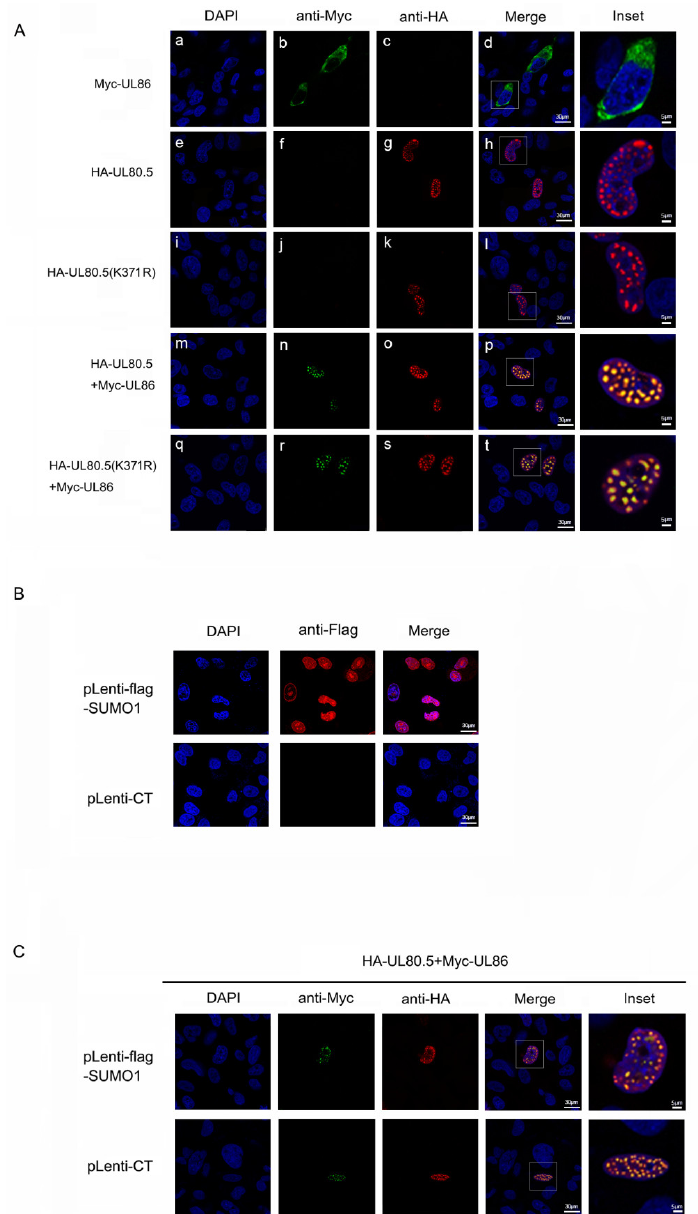
Figure 5. SUMOylation of UL80.5 has no effect on translocating UL86 into cell nucleus. ( A ) U251 cells were transfected with HA-UL80.5/HA-K371R alone, Myc-UL86 alone, or HA-UL80.5/HA-K371R and Myc-UL86. Subcellular localizations of HA-UL80.5/HA-K371R (red), Myc-UL86 (green), and the nucleus marker DAPI (blue) were examined by confocal microscopy. Scale bars for DAPI, anti-Myc, anti-HA, and Merge are 30 µm, and the scale bar for inset is 5 µm. Data are representative of three independent experiments. ( B ) U251 cells were infected with lentivirus expressing flag-SUMO1 (pLenti-flag-SUMO1) or pLenti-CT and selected with puromycin; thus, SUMO1 was stably overexpressed or not. Subcellular localizations of flag-SUMO1 (red) and the nucleus marker DAPI (blue) were examined by confocal microscopy. The scale bar is 30 µm. Data are representative of